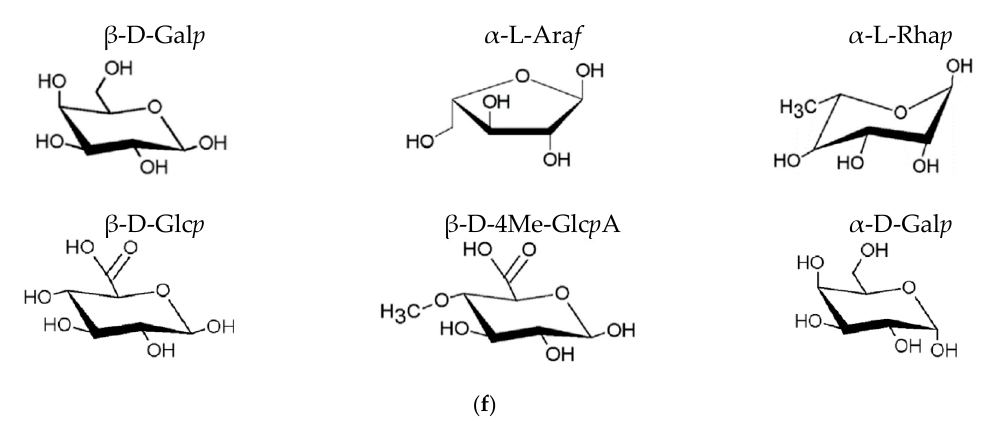
Figure 1. The chemical structures of the organic additives investigated: ( a ) Cetyl trimethyl ammonium bromide (CTAB), ( b ) dodecyl sulphate sodium salt (SDS), ( c ) polyethylene glycol (PEG), ( d ) polyethylene glycol tert-octylphenyl ether (Triton X–100), ( e ) gelatin, ( f ) main monosaccharides present in gum arabic. Figure 1f is reproduced with permission from [30]. Copyright 2015 Elsevier.